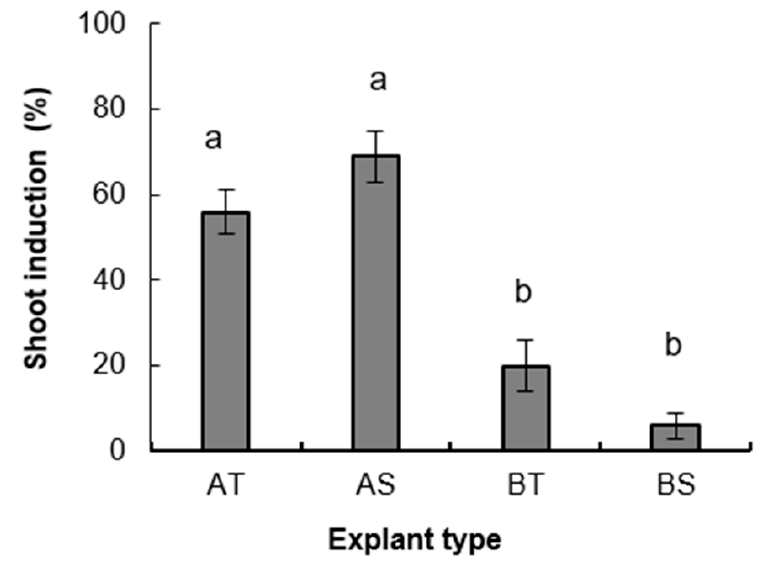
Figure 3. Shoot induction (%) in different explant types of Cryptomeria japonica cultured in DCR medium [13], MS medium [14], and QL medium [15]. Apical explants > 1.5 cm (AT), apical explants < 1.0 cm (AS), basal explants > 1.5 cm (BT), and basal explants < 1.0 cm (BS). Data are presented as mean values ± S.E. Significant differences are indicated by different letters according to Tukey’s post hoc test ( p < 0.05).